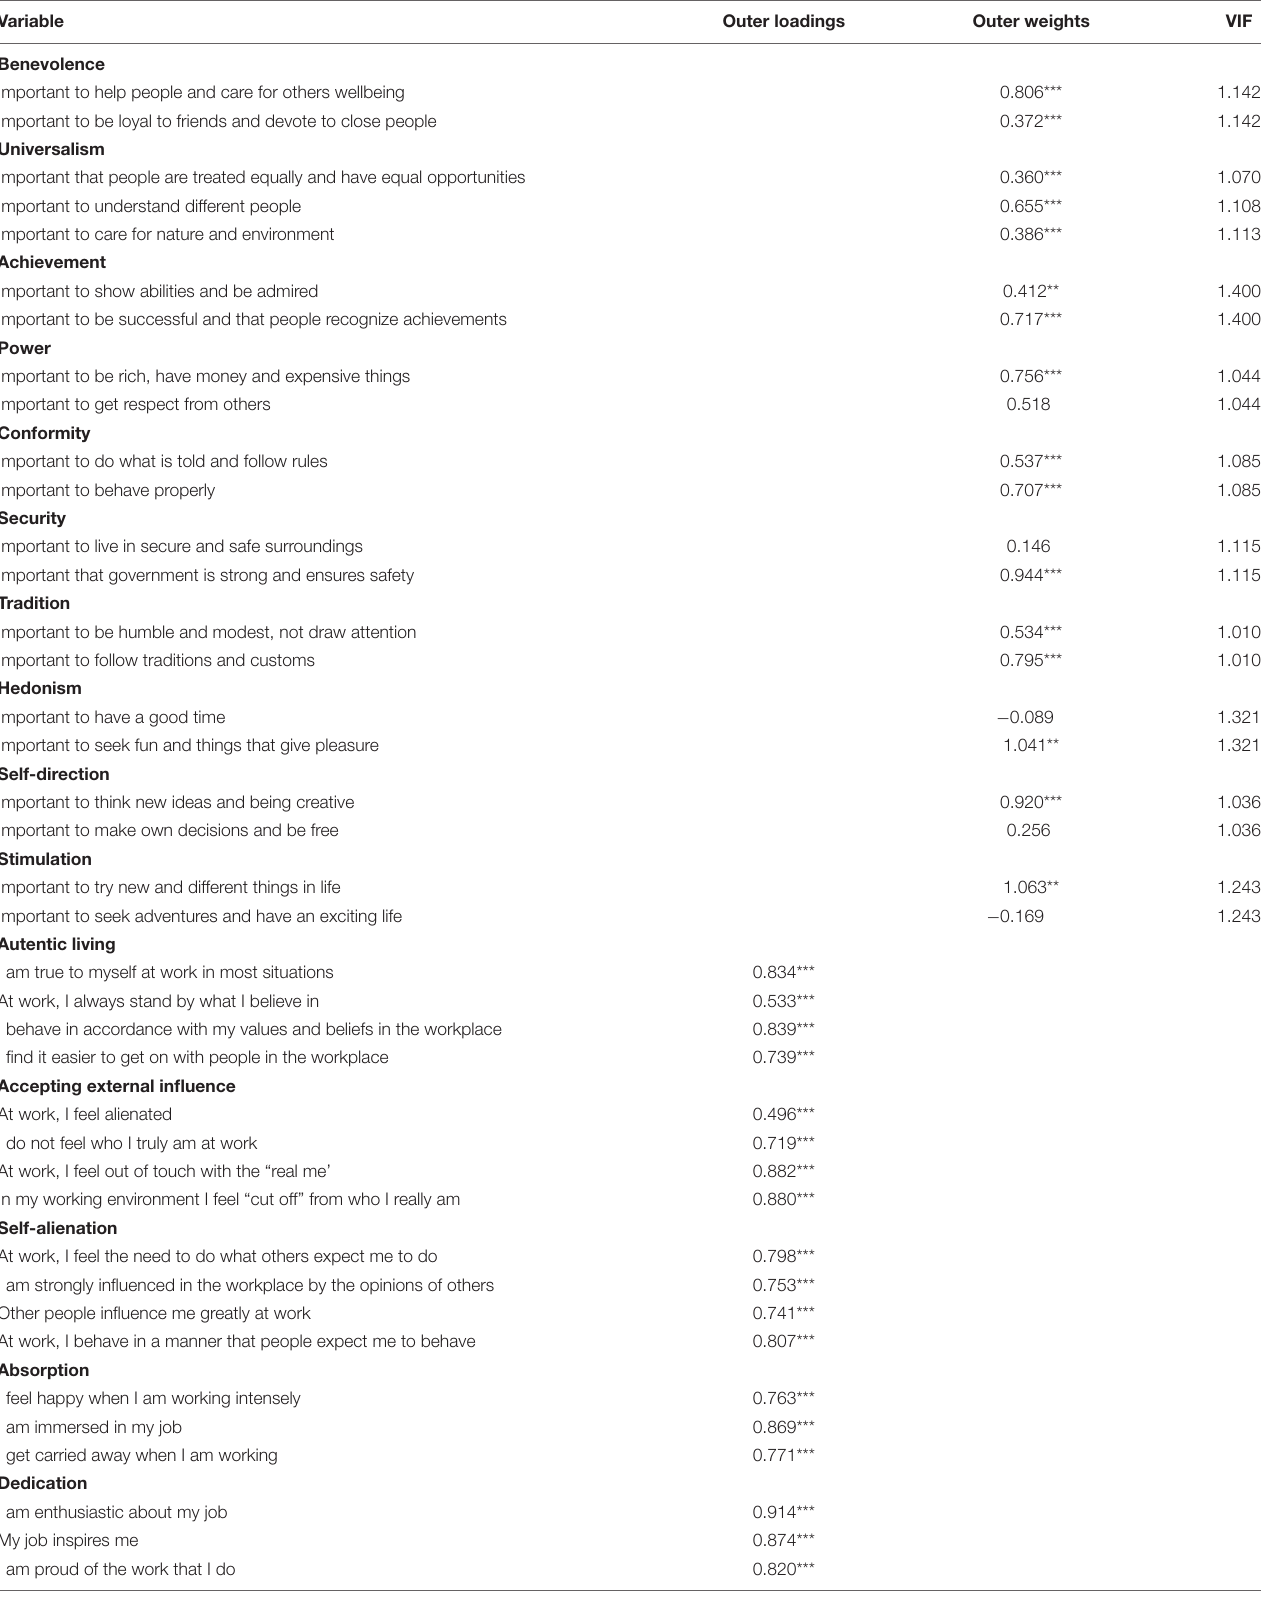
TABLE 3 | Measurement model 1 and reliability and